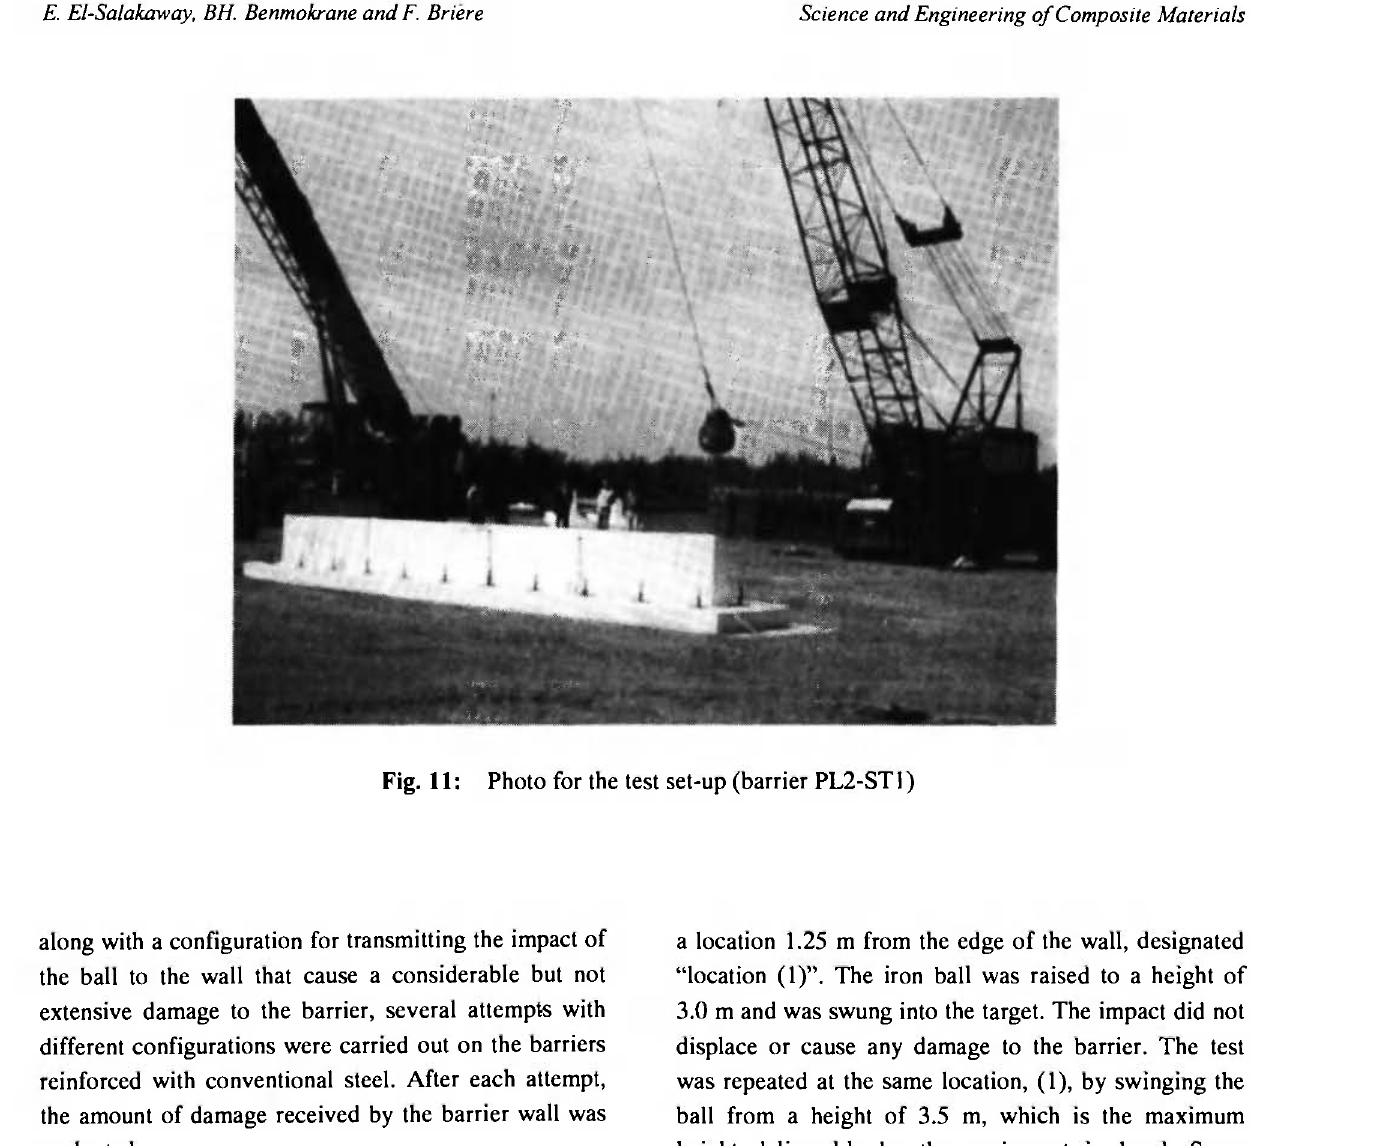
Fig. 11 : Photo for the test set-up (barrier